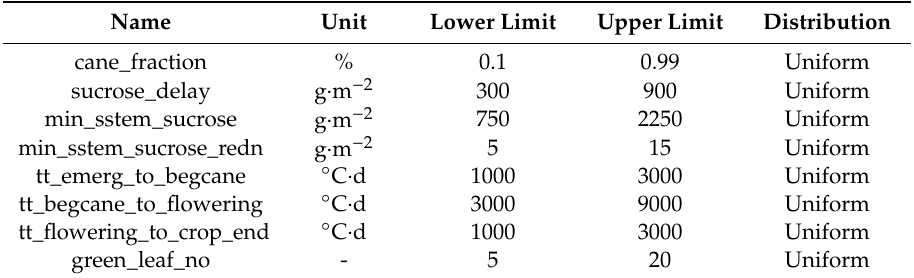
Table 8. Upper and lower limits of sugarcane variety parameters for the sensitivity